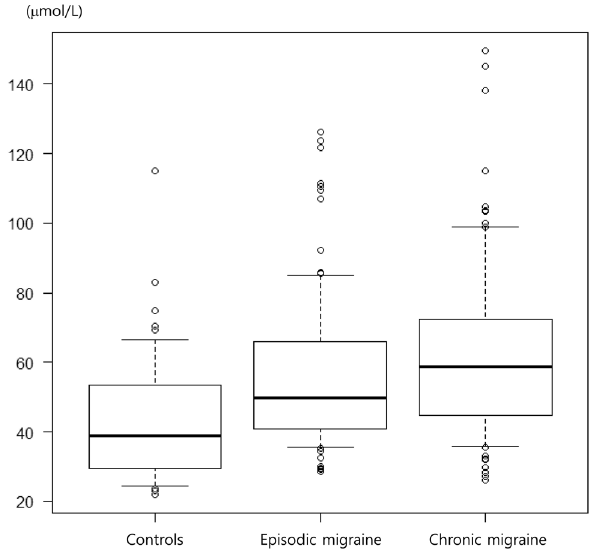
Figure 1. Box plot showing plasma glutamate levels in patients with episodic migraine (n = 98), chronic migraine (n = 92), and healthy controls (n = 50). In the box plots, the boundary of the box closest to zero indicates the 25th percentile. A black line within the box marks the median. The boundary of the box farthest from zero indicates the 75th percentile. Whiskers above and below the box indicate the 10th and 90th percentiles, respectively.